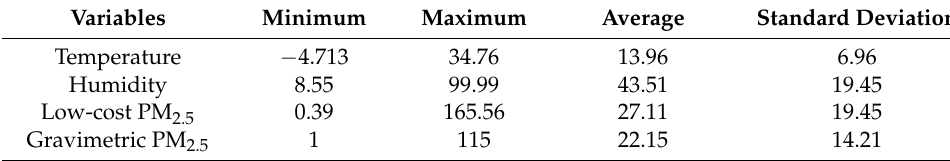
Table 1. Results of statistical information for dataset sampled from low-cost sensor and gravimetric instruments (units of temperature, humidity and PM 2.5 concentration:°C, % and µ g/m 3 ) . The dataset is used to validate the accuracy performance of calibrated